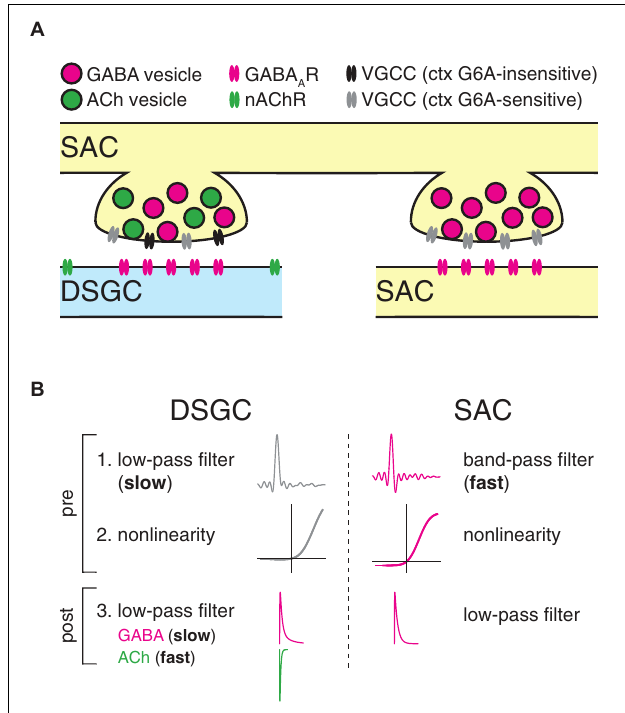
FIGURE 10 | Proposed model for postsynaptic cell type-specific computation at GABAergic SAC synapses. (A) Summary diagram illustrating distinct molecular composition of SAC output synapses. Two neighboring output varicosities on a presynaptic SAC neurite participate in separate synapses with a direction-selective ganglion cell dendrite (DSGC, blue) and a SAC neurite (SAC, yellow). Synaptic transmission onto DSGCs is mediated by a heterogeneous population of VGCCs. Extrasynaptic localization of nicotinic ACh receptors reflects a presumed paracrine mode of ACh transmission (Pottackal et al., 2020; Sethuramanujam et al., 2021). By contrast, synaptic transmission onto SACs is mediated by a homogenous population of